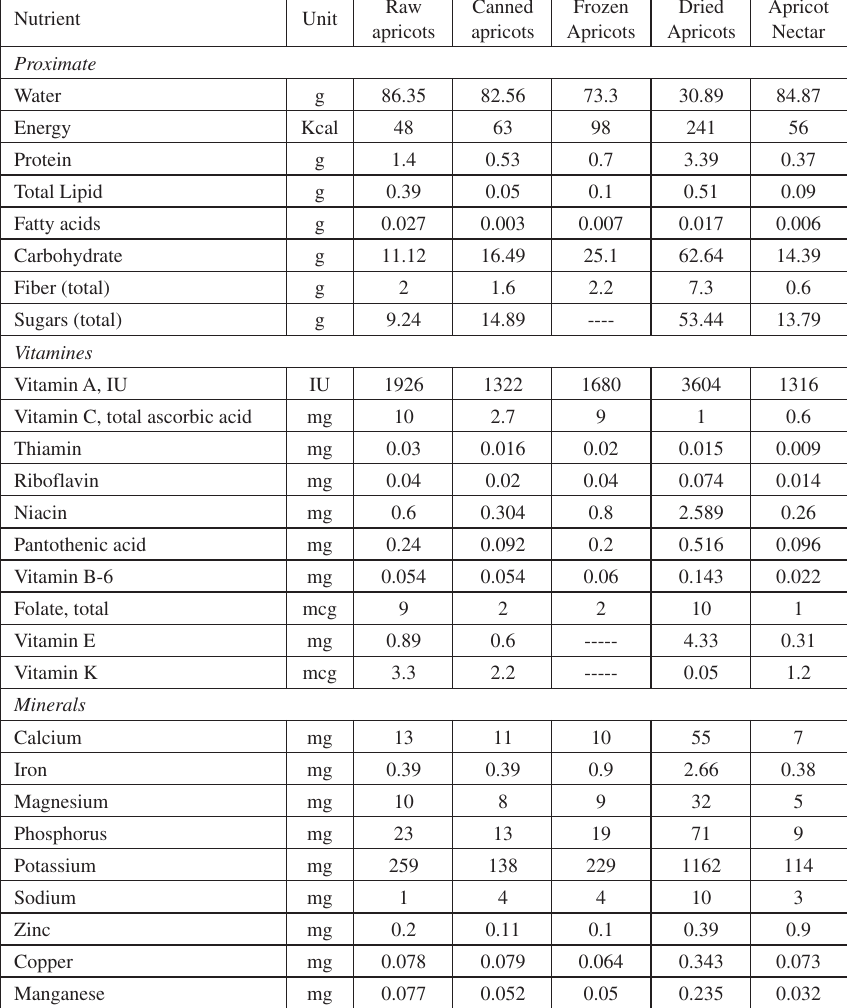
Table 1. Composition of Apricots and their Processed Products (per 100 g edible portion)